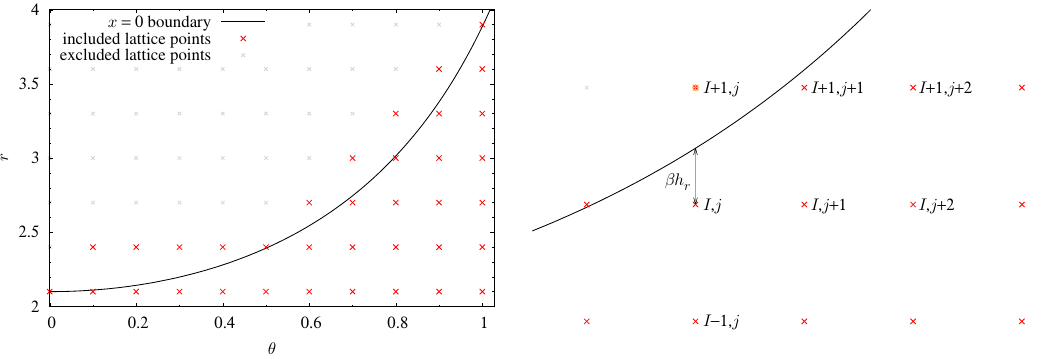
Figure 12 . Boundary (gluing) conditions at x = 0 for the discretized (lattice) problem. This exam- ple is shown for N = 1 , m = 1 and a = 0 . 1 with an exaggeratedly big step size of 0 . 3 chosen for illus- trative purposes. The right-hand panel shows a zoom with the lattice coordinates used in eq.